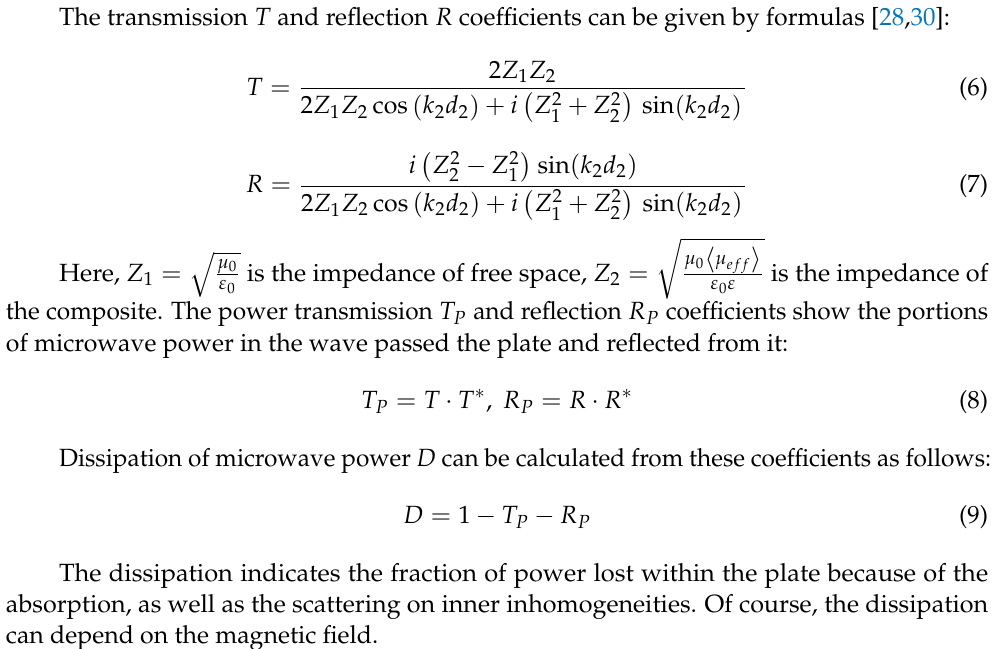
Figure 11. Magnetic field dependences of the real and imaginary parts of the effective permeability ( a ) and wave number ( b ) for the composite containing 7% of spherical ferromagnetic particles at the frequency of 26 GHz.